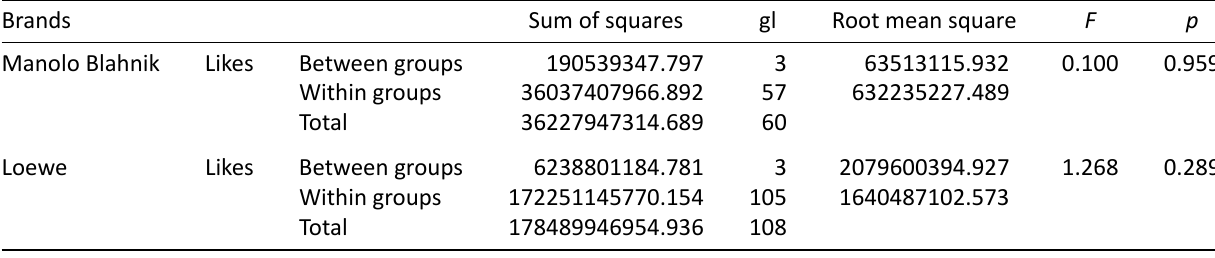
Table 3. ANOVA statistic of sentiments “likes” as a function of brand content.